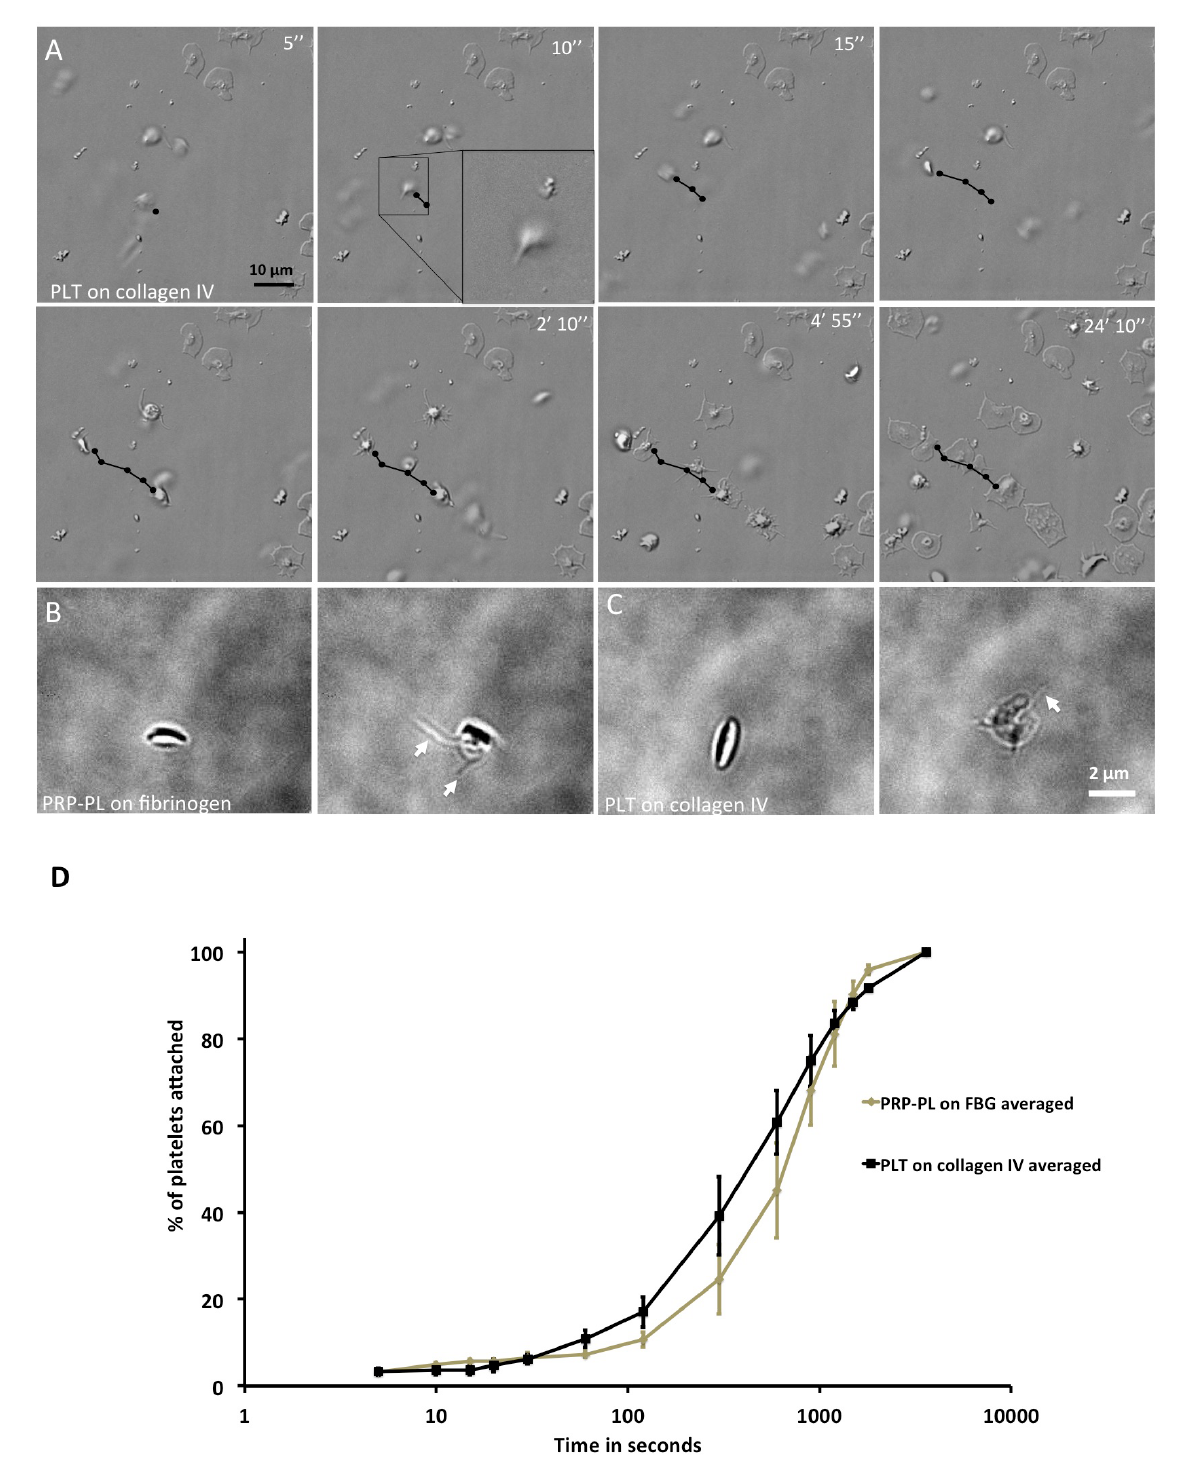
Figure 1. Observations of filopodia on platelets in solution on fibrinogen and collagen IV. ( A ) DIC, time-lapse microscopy of platelets attaching to collagen IV at different time points. Black arrow denotes the platelet in question. Scale bar: 10 μm. ( B ) Phase-contrast microscopy of PRP-PL on fibrinogen. Left: Discoid shape; Right: Platelet with filopodial extension. Scale bar: 5 μm. ( C ) Phase-contrast microscopy of PLT on collagen IV. Left: Discoid shape; Right: Platelet with filopodial extension. Scale bar: 5 μm. ( D ) Platelet attachment to collagen IV or fibrinogen in percentage (%) over time. Time in seconds, on a logarithmic scale. Platelets on collagen IV attach faster that on fibrinogen. Wilcoxon rank-sum test, p-value < 0.015. N platelets: FBG=121, collagen IV=274. Error bars show Standard Error.